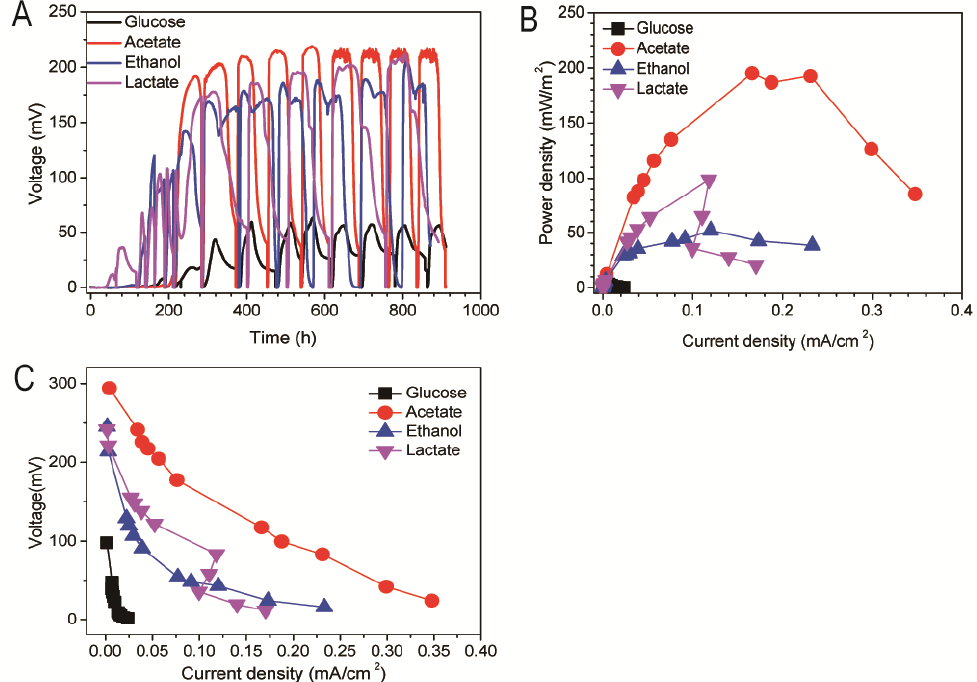
Figure 2. The output voltage ( A ), power density ( B ), and polarization curve ( C ) of MFCs containing bioelectroactive biofilms enriched with different energy substrates.